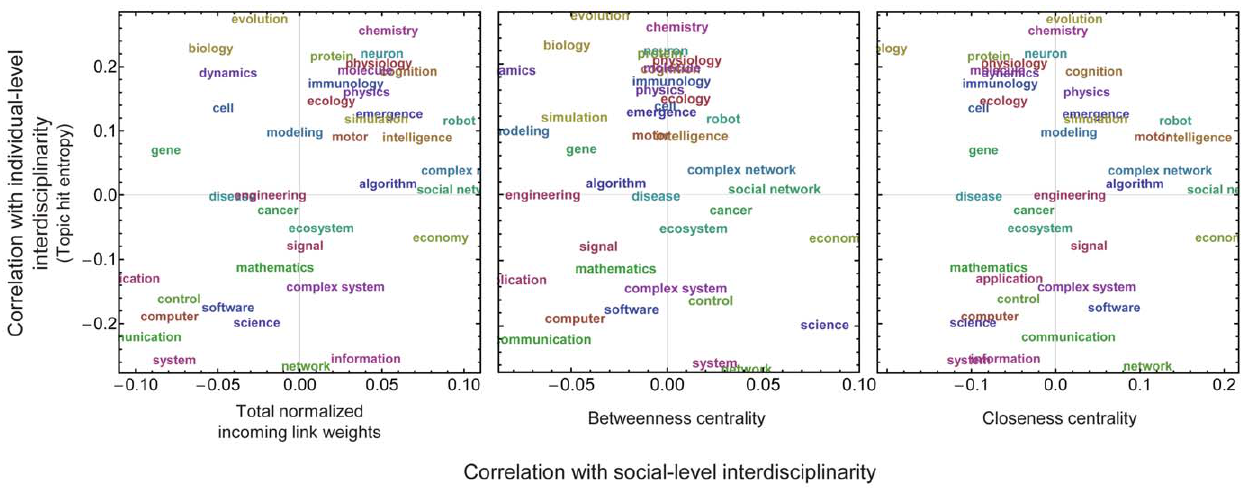
Figure 7. Two dimensional maps summarizing each research topic’s correlations with a researcher’s individual-level interdisciplinarity (vertical, topic hit entropy) and social-level interdisciplinarity (horizontal, three centrality measurements).